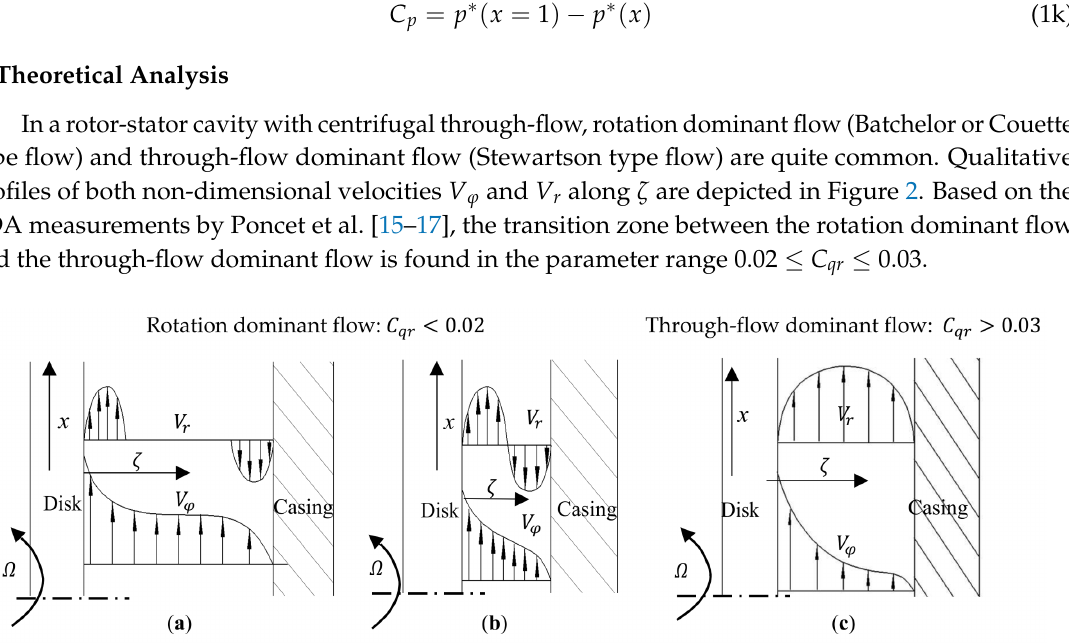
Figure 2. Velocity profiles for both the rotation dominant flow and the through-flow dominant flow: ( a ) Batchelor type flow; ( b ) Couette type flow and ( c ) Stewartson type flow. C qr : local flow rate coefficient; V r : non-dimensional radial velocity; V ϕ : non-dimensional tangential velocity; x : non-dimensional radial coordinate; ζ : non-dimensional axial coordinate; Ω : angular velocity of the